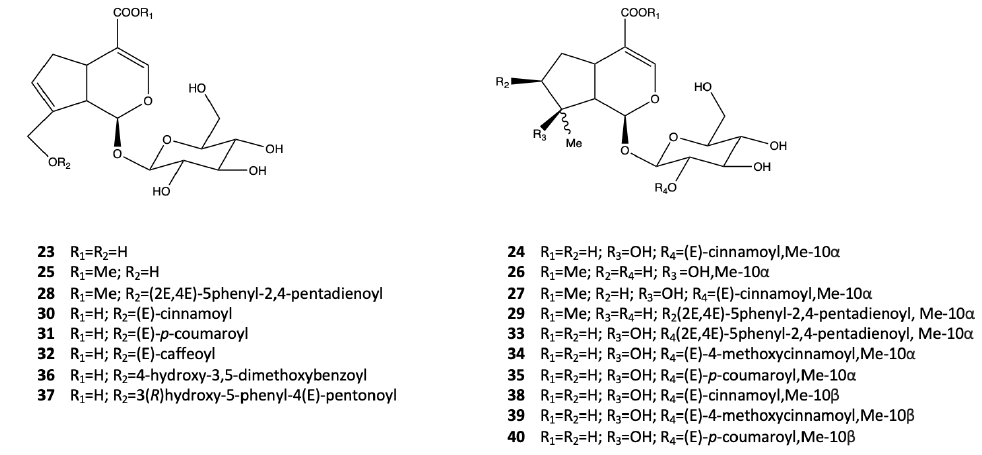
Figure 4. Iridoid glucosides from A. marina .